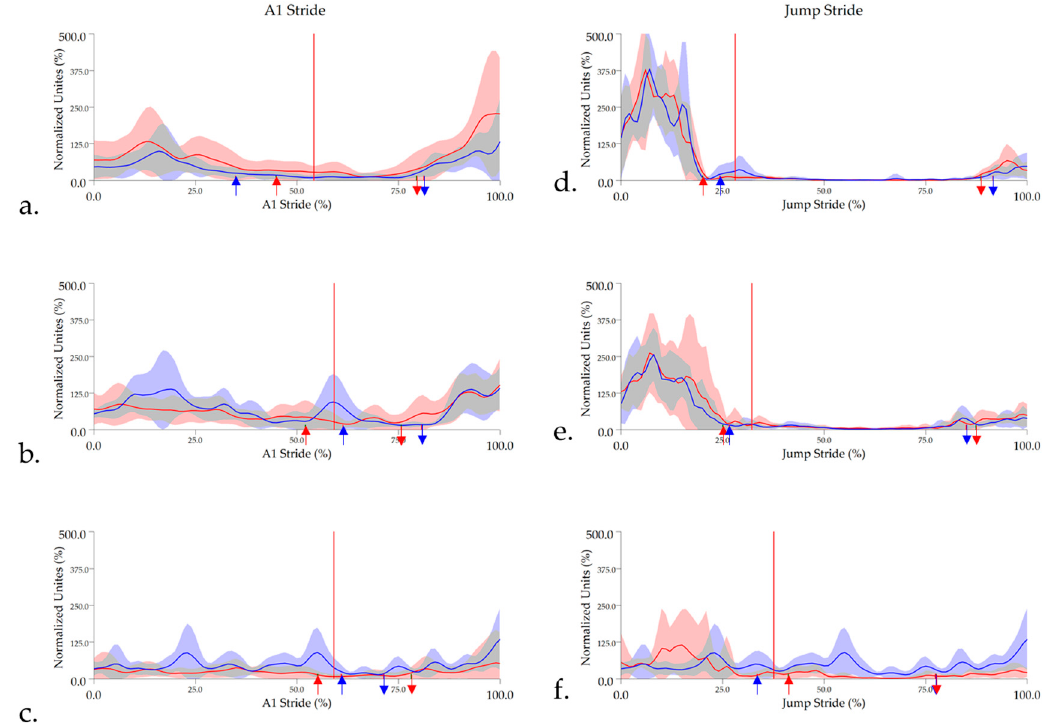
Figure 6. Mean and standard deviation time and amplitude-normalized, linear enveloped sEMG signals from gluteal for ( a ) High CM , ( b ) Int CM , and ( c ) Low CM horses during approach (A1) stride and ( d ) High CM , ( e ) Int CM , and ( f ) Low CM during jump stride. sEMG signals are DC-offset, high-pass filtered (40 Hz cut-off) and low-pass filtered (25 Hz). Mean data are presented for leading hindlimb (LdH) (red line) and trailing hindlimb (TrH) (blue line), with shaded areas representing the standard deviation for each limb. Arrows represent the mean gluteal activity onset (downward arrows) and offset (upward arrows) events for LdH (red arrows) and TrH (blue arrows). Red vertical lines represent the average hindlimb lift-off event within each group.